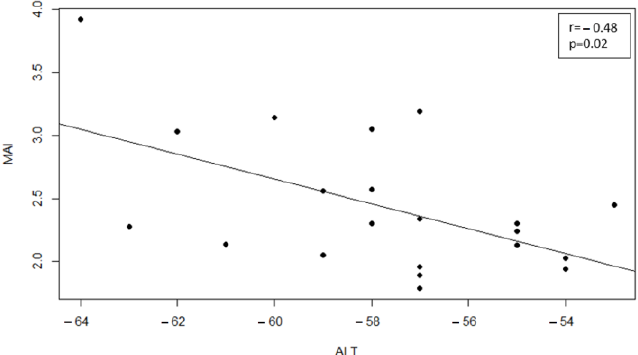
Figure 2. Correlation between clinical scores. Scatter plot of ALT and MAI.